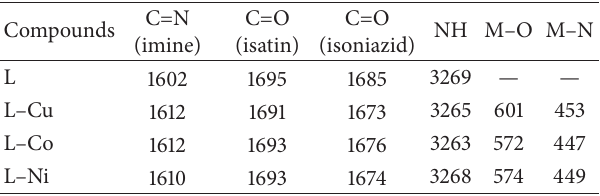
Table 2: Infrared spectral data for the free ligand and their complexes in KBr disc (cm − 1